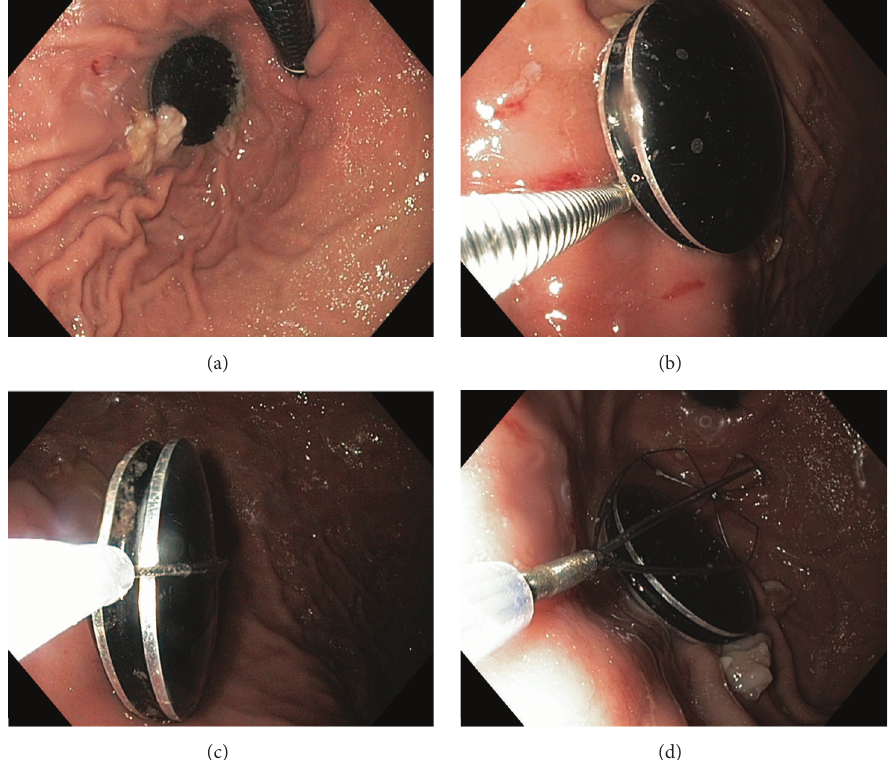
Figure 2: Watch shown in gastric fundus on retroflexion (a) and failed attempts at retrieval using biopsy forceps (b), transverse capture with a snare (c), and wire basket